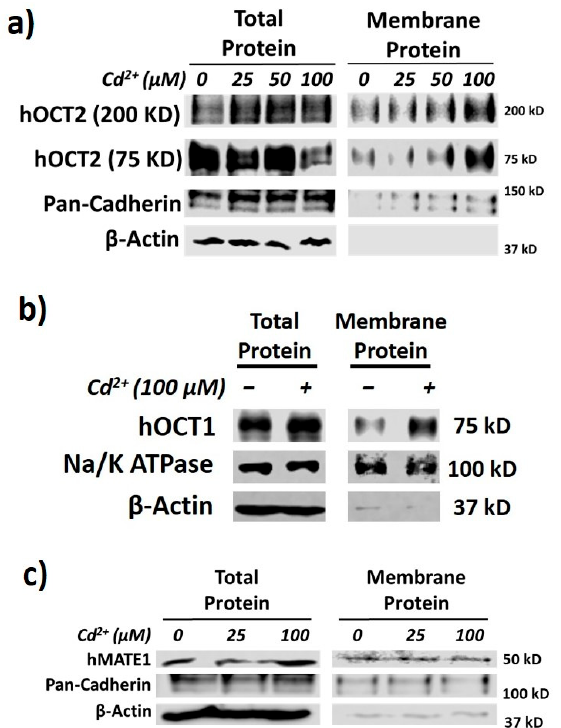
Figure 2. Cd 2+ exposure increases membrane expression of hOCT1 and hOCT2 but not hMATE1. ( a ) Immunoblotting (IB) analysis of total and membrane fraction of hOCT2 in HEK-hOCT2 cells with and without exposure to different concentrations of Cd 2+ for 20 min. ( b ) IB analysis of total and membrane fraction of hOCT1 in HEK-hOCT1 cells with and without exposure to Cd 2+ for 20 min. ( c ) IB analysis of total and membrane fraction of hMATE1 in HEK-hMATE1 cells with and without exposure to different concentrations of Cd 2+ for 20 min. All figures are representatives of three independent experiments. Pan-cadherin and Na + /K + ATPase are served as the positive control and β -actin as negative control for membrane proteins.